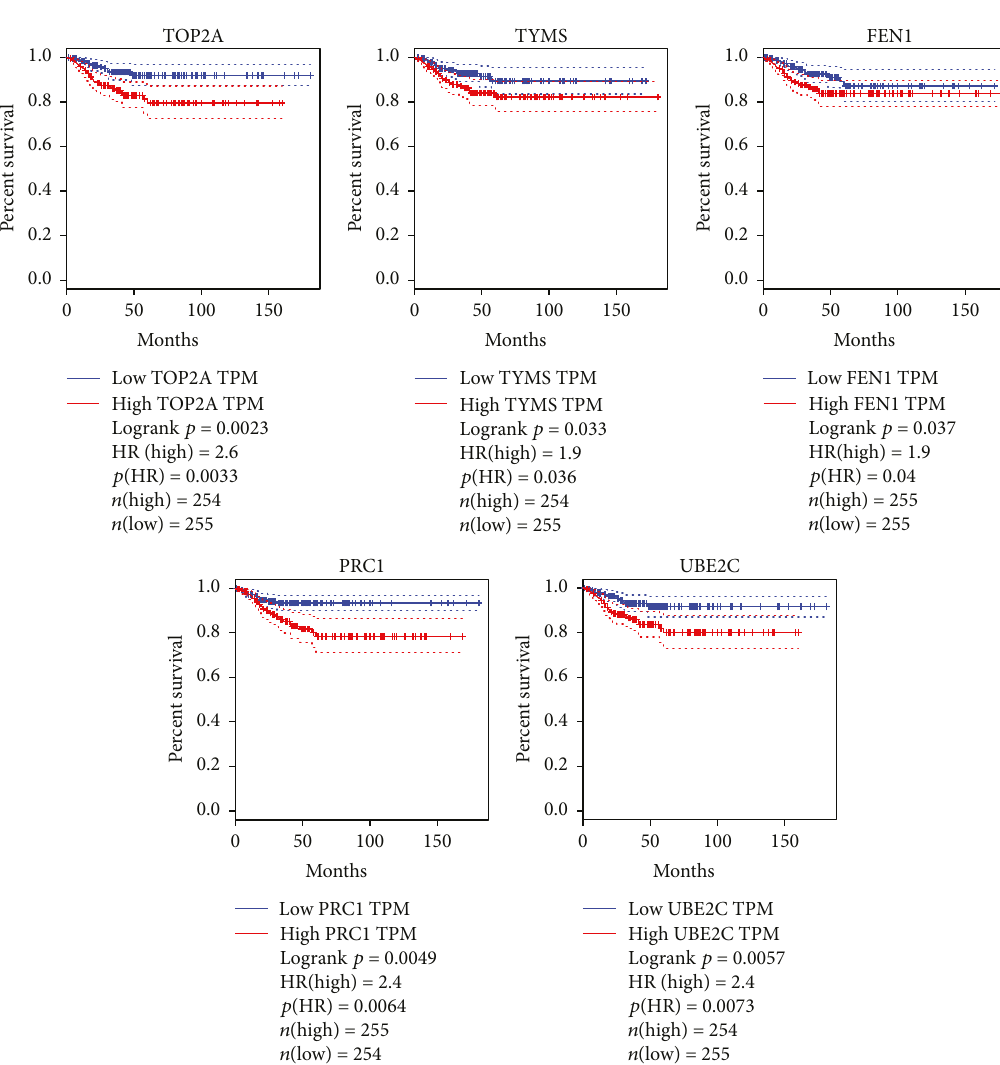
Figure 5: The association of hub gene expression with disease-free survival of patients with other thyroid